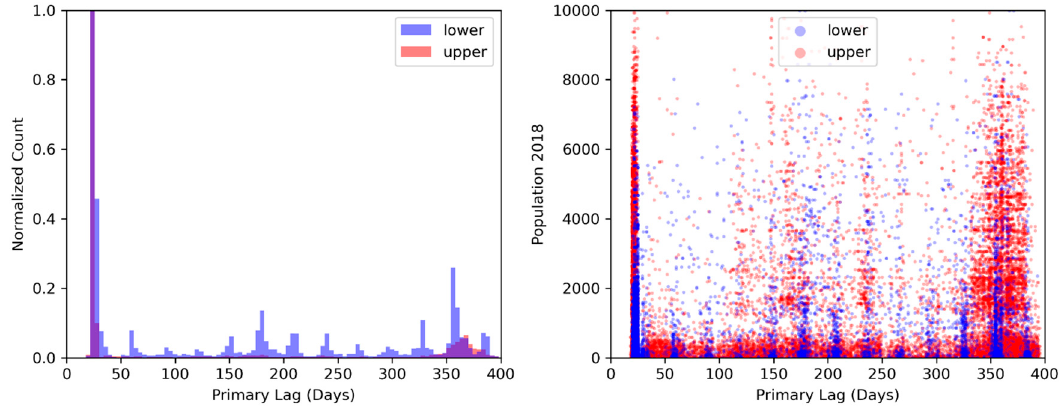
Figure 34. Histogram and scattergram of the 2018 primay cycle lag from the autocorrelation analysis. Values for the developing set (Harare, Nairobi, Dhaka, and Pyongyang) are blue and for the developed set are red (Houston, Seoul, Shanghai, Beijing). The two sets are referred to as “lower” and “upper”, respectively. The sample set excludes grid cells deemed to be permanent background, where no lighting is detected. The scattergram is the lag versus population count from 2018.